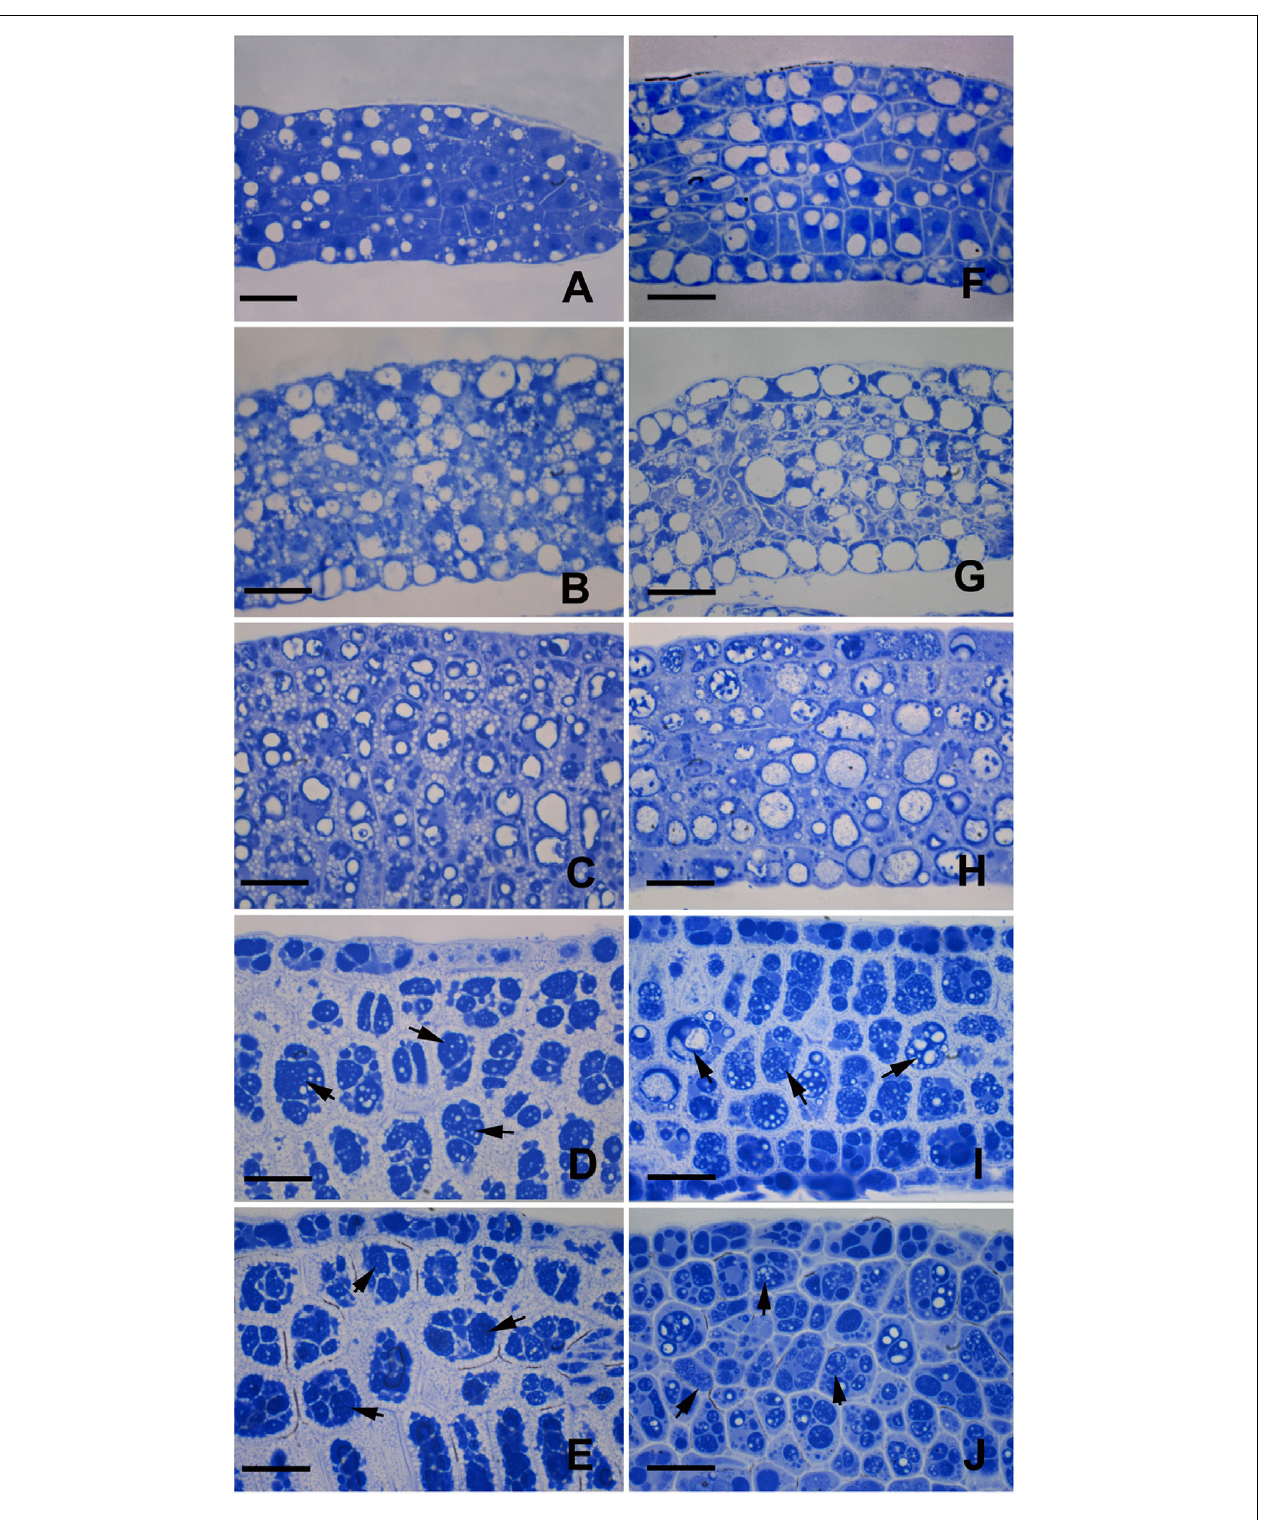
FIGURE 7 | Coomassie brilliant blue staining for total proteins. Semithin sections of both the control (A–E) and treated (F–J) embryos were obtained and stained with Coomassie brilliant blue. (A,F) Embryos grown for 6 DAP. (B,G) Embryos grown for 8 DAP. (C,H) Embryos grown for 10 DAP. (D,I) Embryos grown for 12 DAP. (E,J) Embryos grown for 14 DAP. Arrowheads indicate proteins accumulated in PSVs. Bar = 20 µ m.